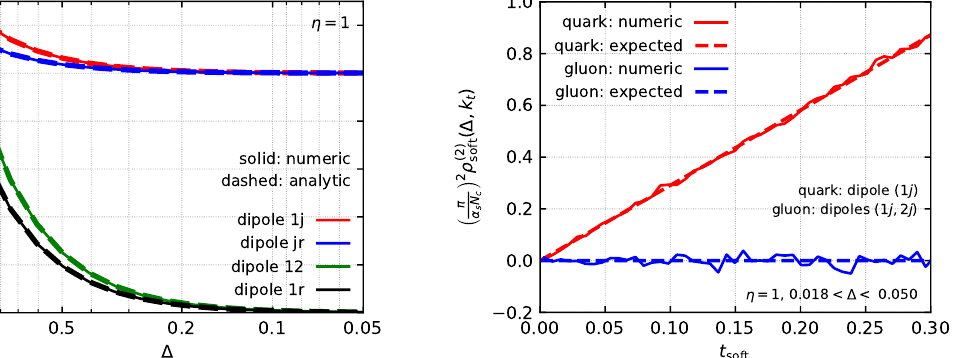
Figure 3. Comparisons at (cid:12)xed order between our numerical results for soft gluon radiation (solid lines) and analytic predictions from sections 3.3.1 and 3.3.2 (dashed